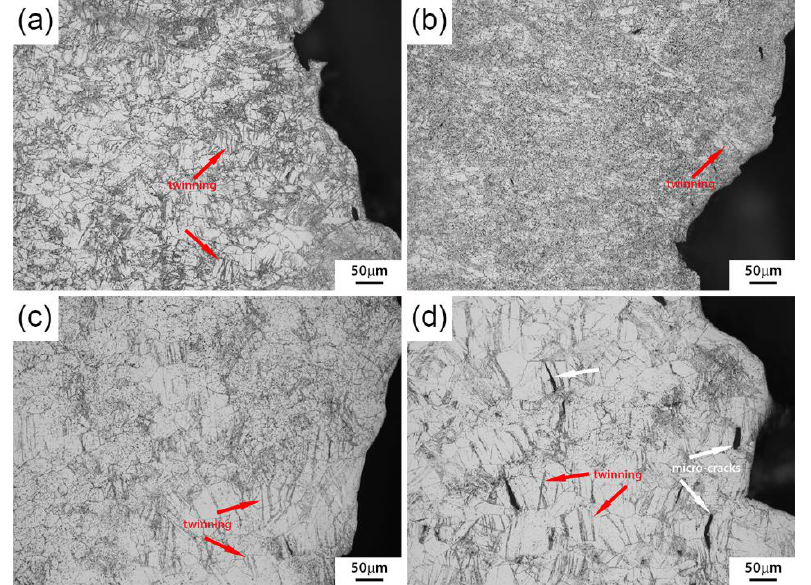
Figure 10. The Schmid Factor value of the as-rolled and annealed plates along the three tensile directions.